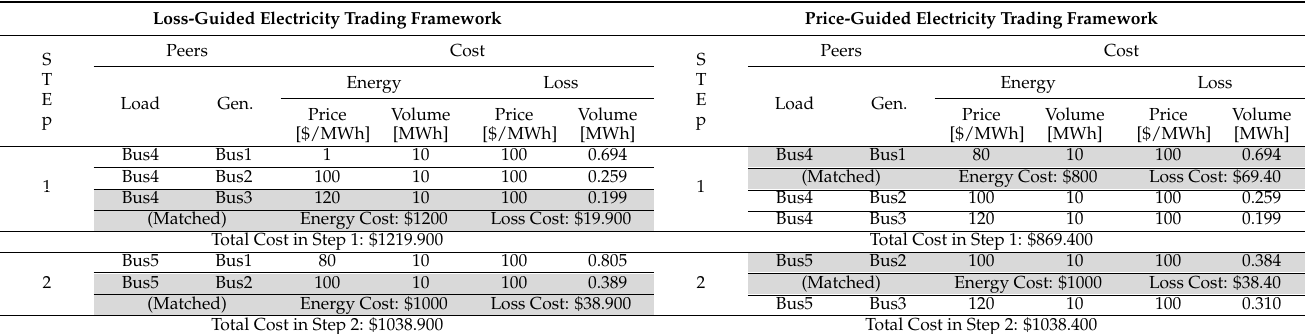
Table 1. Loss-guided and Price-guided Electricity Trading Framework Result. Loss-Guided Electricity Trading Framework